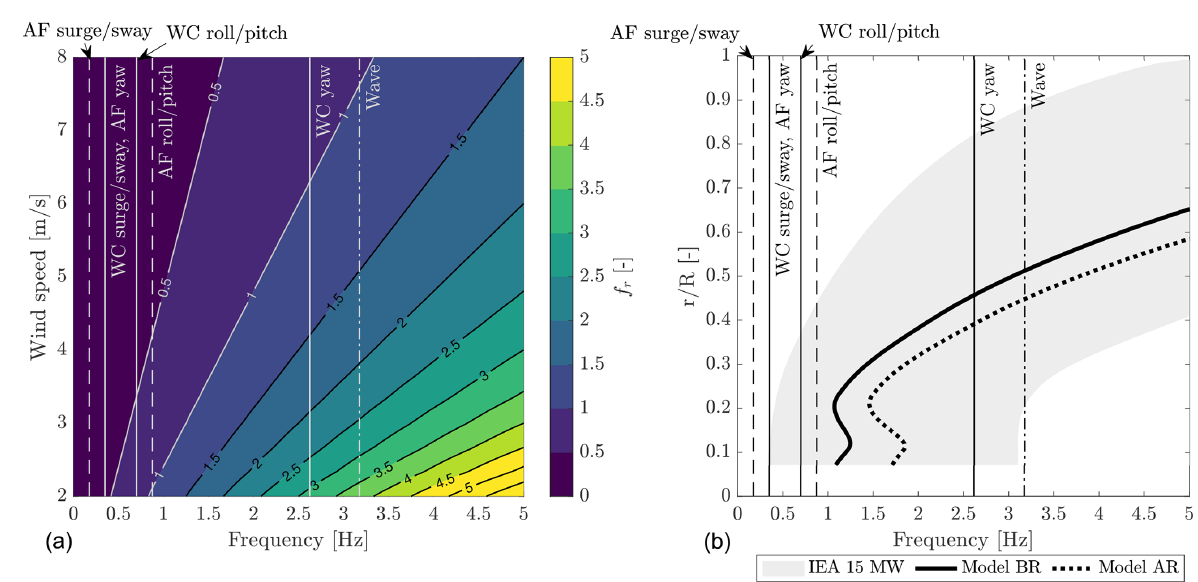
Figure 2. (a) Rotor reduced frequency as a function of motion frequency and wind speed; the reduced frequencies of the load cases are identified by markers (WC1 is wind condition 1, WC2 wind condition 2). Notice the heave frequency of the two platforms is not shown because heave motion was not investigated. (b) The threshold motion frequency beyond which blade-level unsteady aerodynamics may occur for the turbine model is compared to the motion frequencies of the experiments (AF is Activefloat, WC is WindCrete); the shaded area covers the threshold frequency for the IEA 15MW in its operating